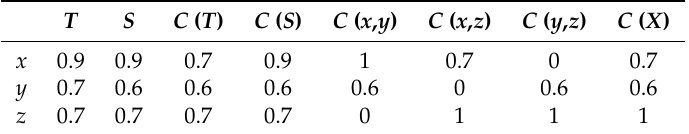
Table 3. The choice function and feasible subsets in Example 3. We omit brackets for simplicity. T S C ( T ) C ( S ) C ( x , y ) C ( x , z ) C ( y , z ) C ( X